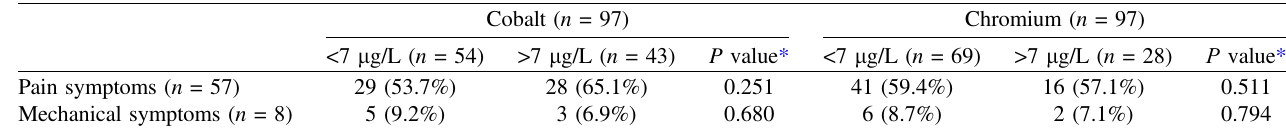
Table 1. Association of blood Chromium and Cobalt levels with patient presenting